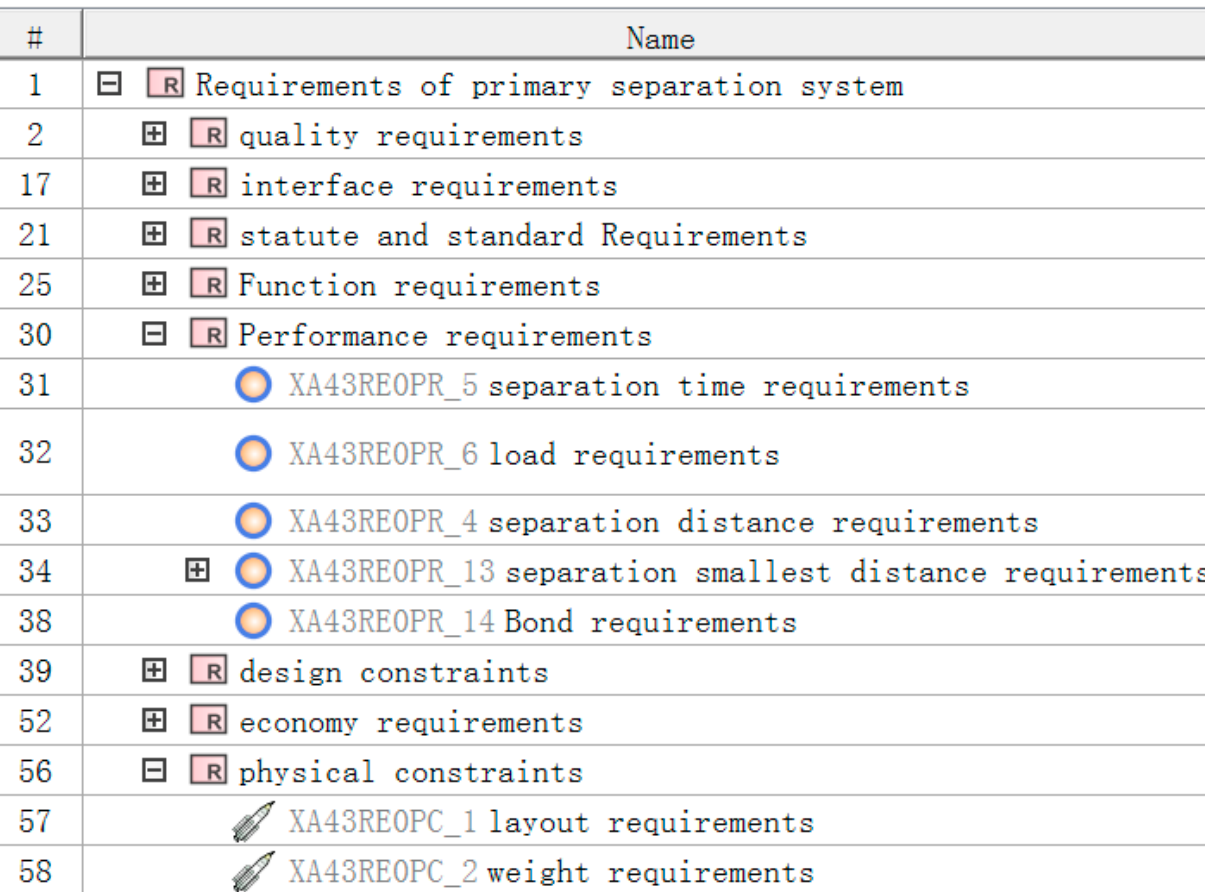
Figure 5. Requirements for the first-stage separation system.